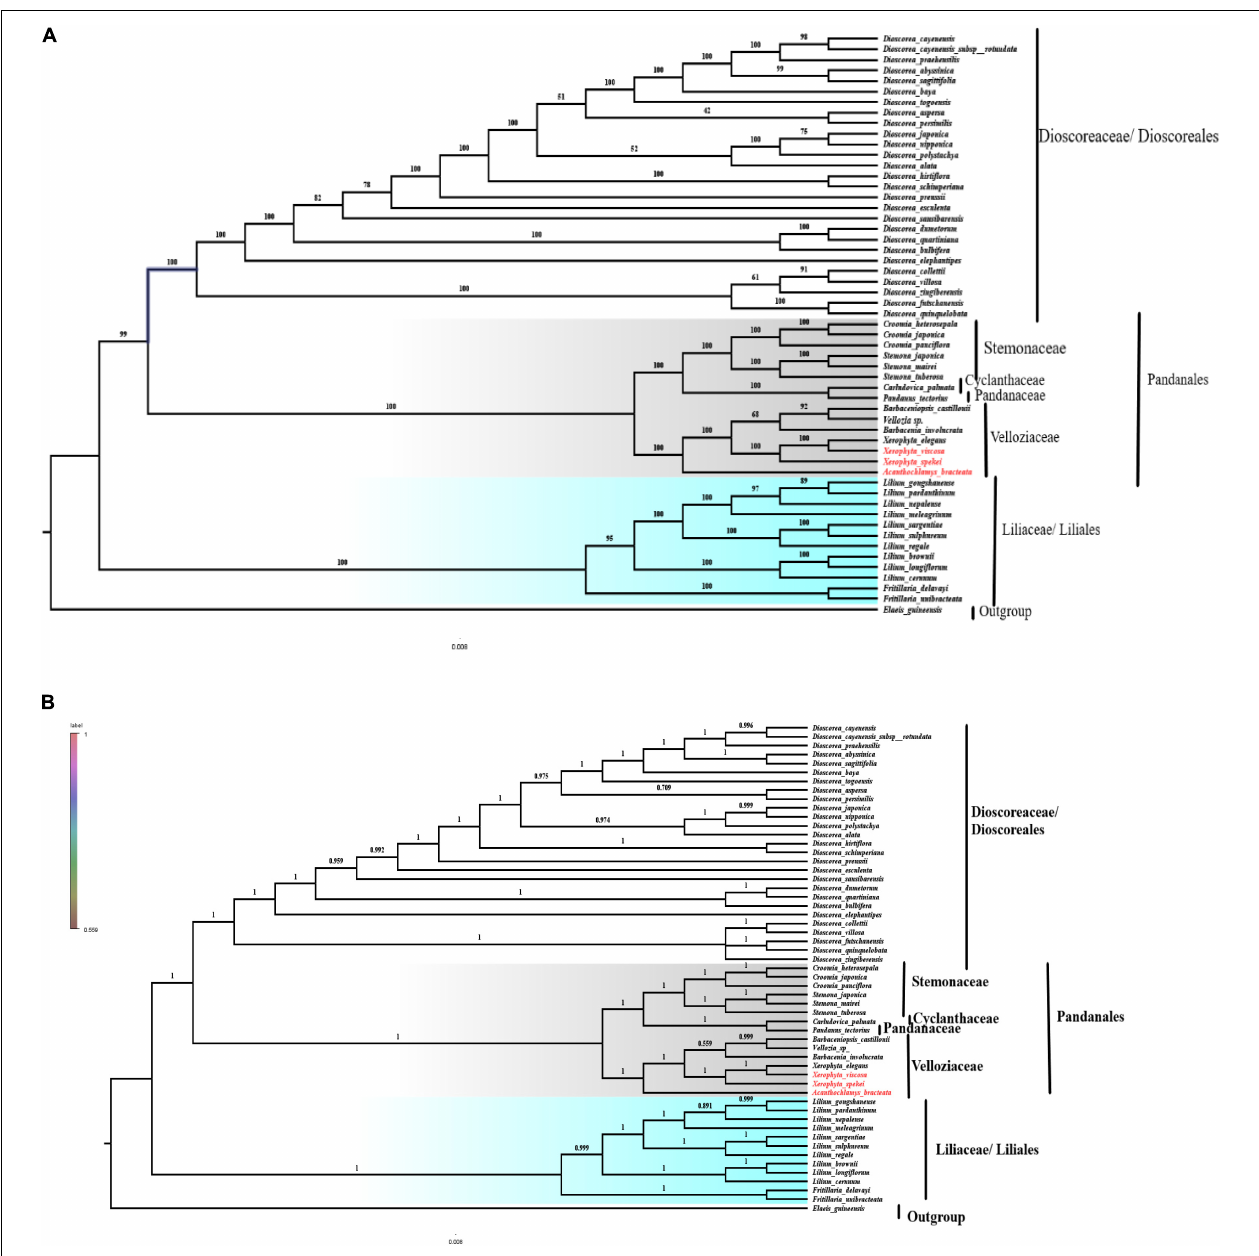
FIGURE 10 | Phylogenetic relationship of the three species of Velloziaceae based on 59 single-copy genes shared by all cp genomes. (A) The Maximum likelihood (ML) tree with bootstrap value on the branches; (B) Bayesian inference (BI) tree with posterior probabilities values on the